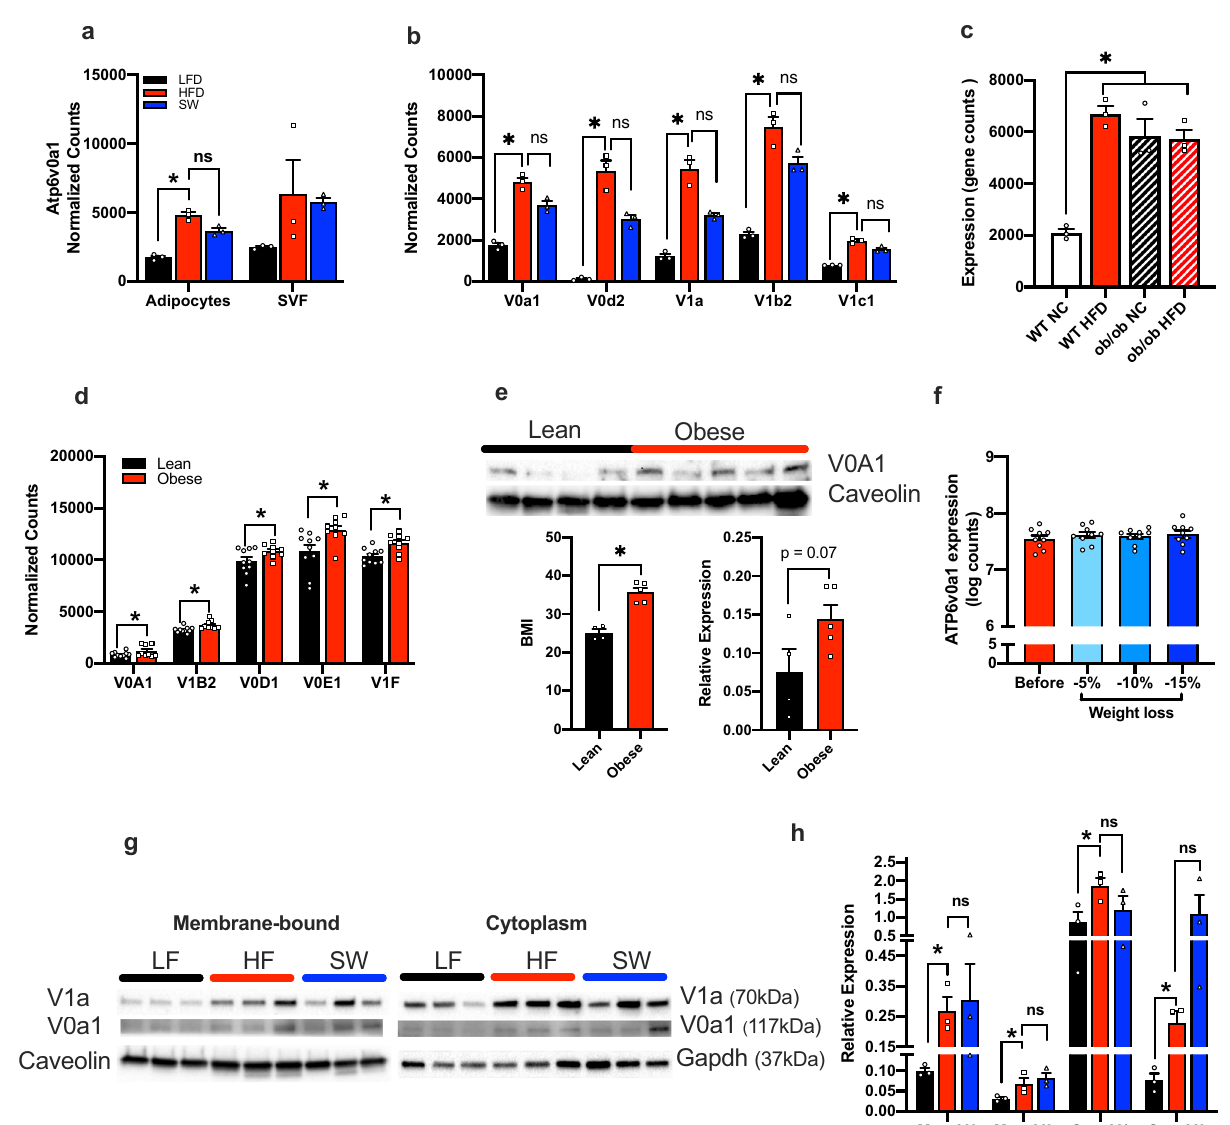
Fig.2|V-ATPaseexpressioninobesity.a Expressionof Atp6v0a1 inlean(LF,black bars),obese(HF,redbars)andformerlyobese(SW,bluebars)micedeterminedby RNA seq, n =3/group, Adipocyte p =0.005. b Expression of V-ATPase subunits in lean, obese and formerly obese mice determinedby RNA seq, *denotes differential expression compared to LF fed mice determined as lfdr<0.05, n =3/group, ( p <0.004 for all LF vs HF comparisons). c Expression of Atp6v0a1 in WT (open bars) andob/obmice (hatchedbars) fedwith normalchow(black/white)and high- fat diet (HFD, red) determined by RNA seq (GEO GSE167264,), n =3/group, p =0.0002. d Adipocyte gene expression of V-ATPase subunits in lean (black bars) and humans with obesity (red bars), ( n =9 – 10) 27 , from Gene Expression Omnibus (GEO: GSE2508) 27 and differential expression between groups determined using GEO2R (default parameters including Benjamini and Hochberg calculation of the false discovery rate, fdr)*=fdr<0.4 (V0A1 fdr=0.36, V1B2=0.18, V0D1=0.35, v0E1=0.16,V1F=0.19). e AT6V0a1expressioninsubcutaneousadiposetissuefrom